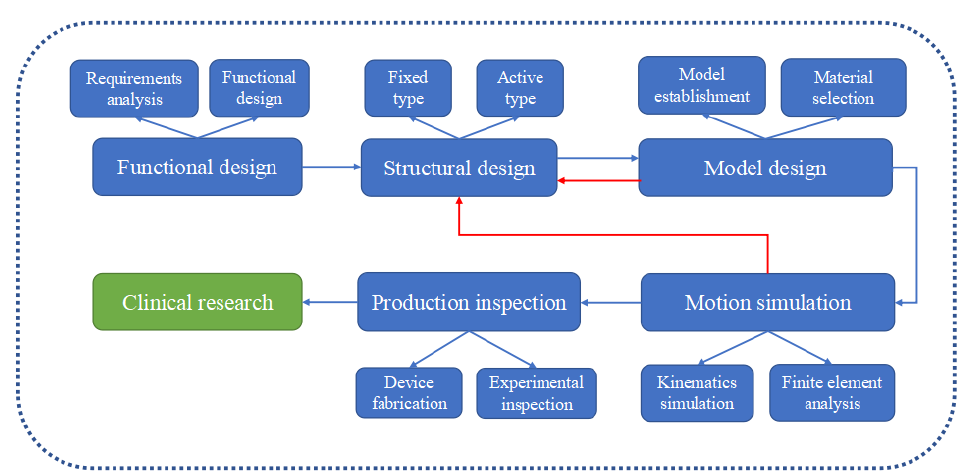
Figure 4. Design and manufactural processes of